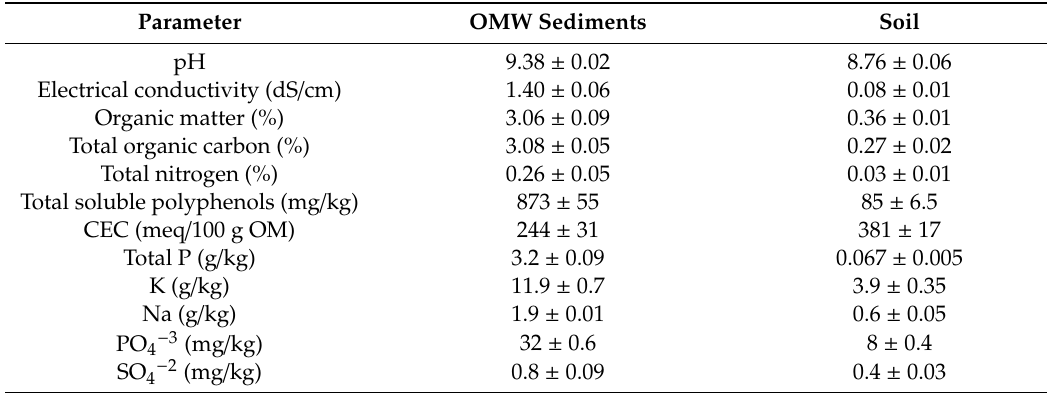
Figure 1. Study area at the locality of Mora (Toledo, Spain). Disposal of olive-mill waste (OMW) in open-air evaporation ponds. Table 1. Selected physicochemical properties (mean ± SD, n = 3) of OMW sediments and soil used in toxicity testing with Lumbricus terrestris .